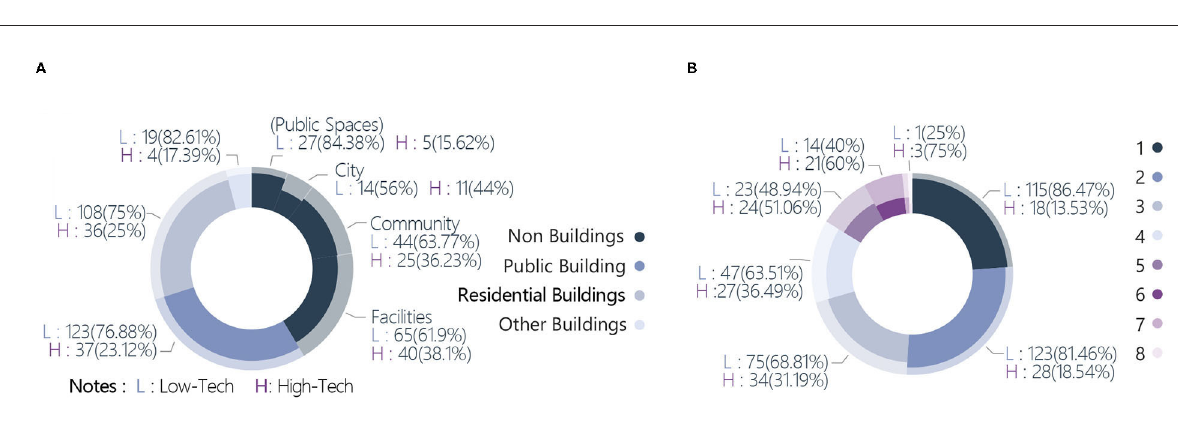
FIGURE13 Cross-tabulation results with technical orientation. (A) Technical orientation and architecture category. (B) Technical orientation and quantity of